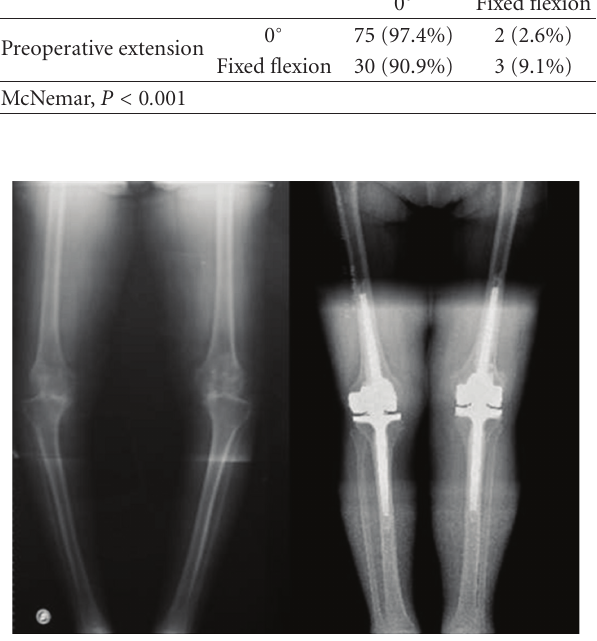
Figure 1: Preoperative X-ray of a patient with a severe bilateral varus deformity. Postoperative image of bilateral prosthesis showing the axial correction.